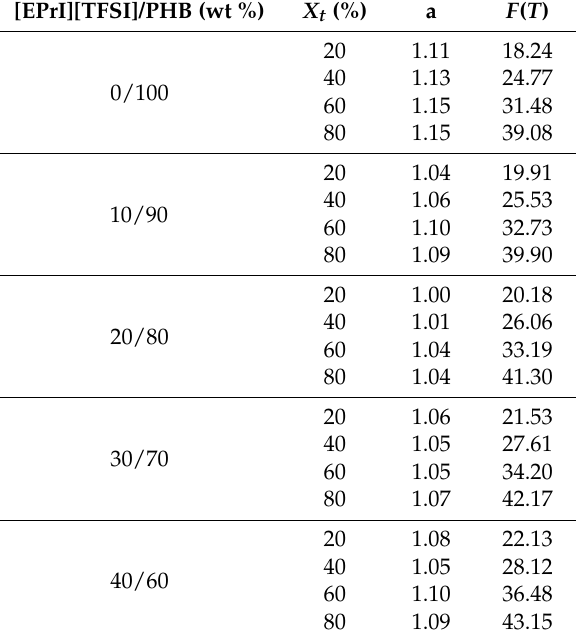
Table 3. Non-isothermal crystallization parameters estimated by the Mo